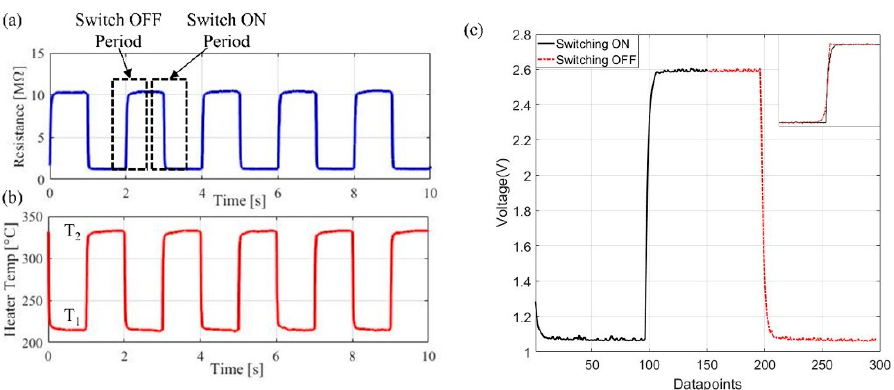
Figure 4. Steps signal processing method used during thermal modulation, the sensor is thermally modulated between two temperatures. ( a ) Change in resistance of a thermally modulated MOX (reference coating used, resistance magnitude does not correspond to gas measurements) and heater temperature shown in ( b ), and ( c ) one step of the raw MOX sensor during measurement, with black line as ‘switching ON’ period and red as ‘switching OFF’